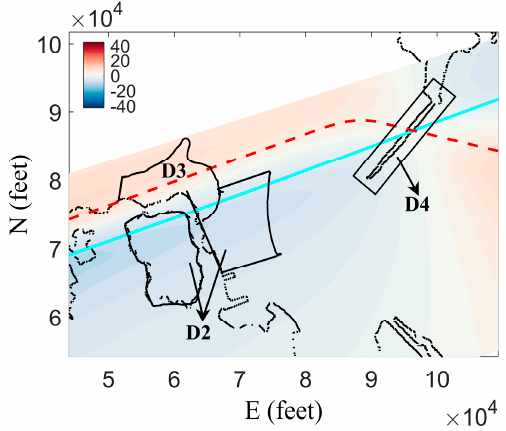
Figure A10. Difference in SEL ( ∆ SEL) between flights AA2 and AA3 (closer view).